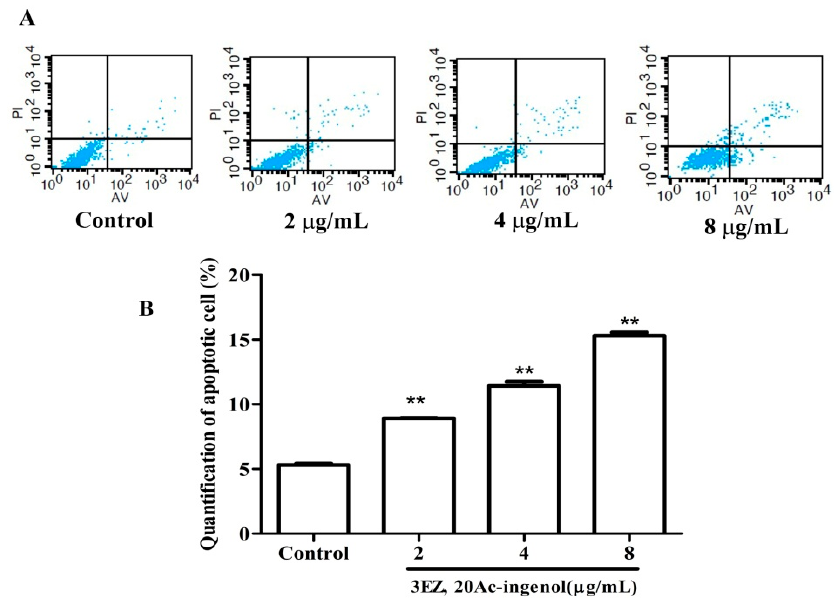
Figure 4. The effects of 3EZ, 20Ac-ingenol on L-O2 cell apoptosis using flow cytometer: ( A ) Images; and ( B ) Quantification of apoptotic cells were analyzed and expressed. Data are presented as mean ± SD from triplicate samples, ** P < 0.01 compared with control group.